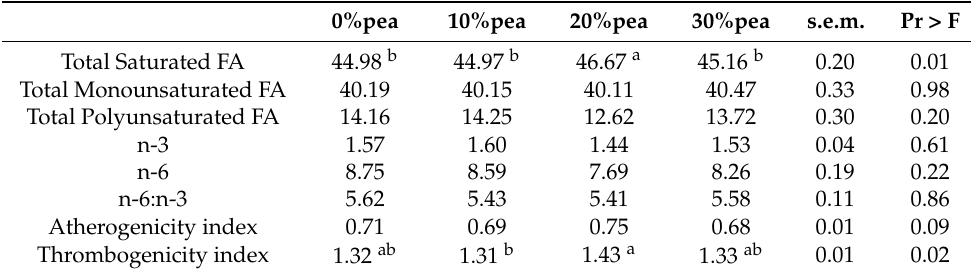
Table 6. Effect of the proportion of pea in the sums and ratios of fatty acids in LTL muscle.